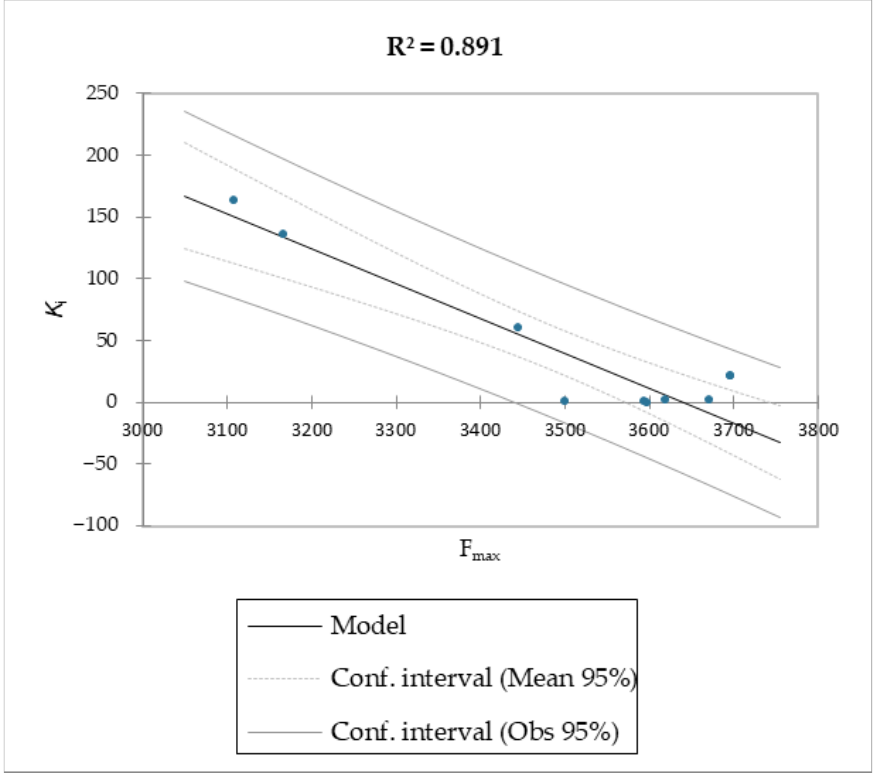
Figure 7. Calculated SMD simulation F max vs. experimental K i of molecules 1 – 9 . Table 5. Goodness of fit statistic for MM/PBSA, MM/GBSA, and F max models.